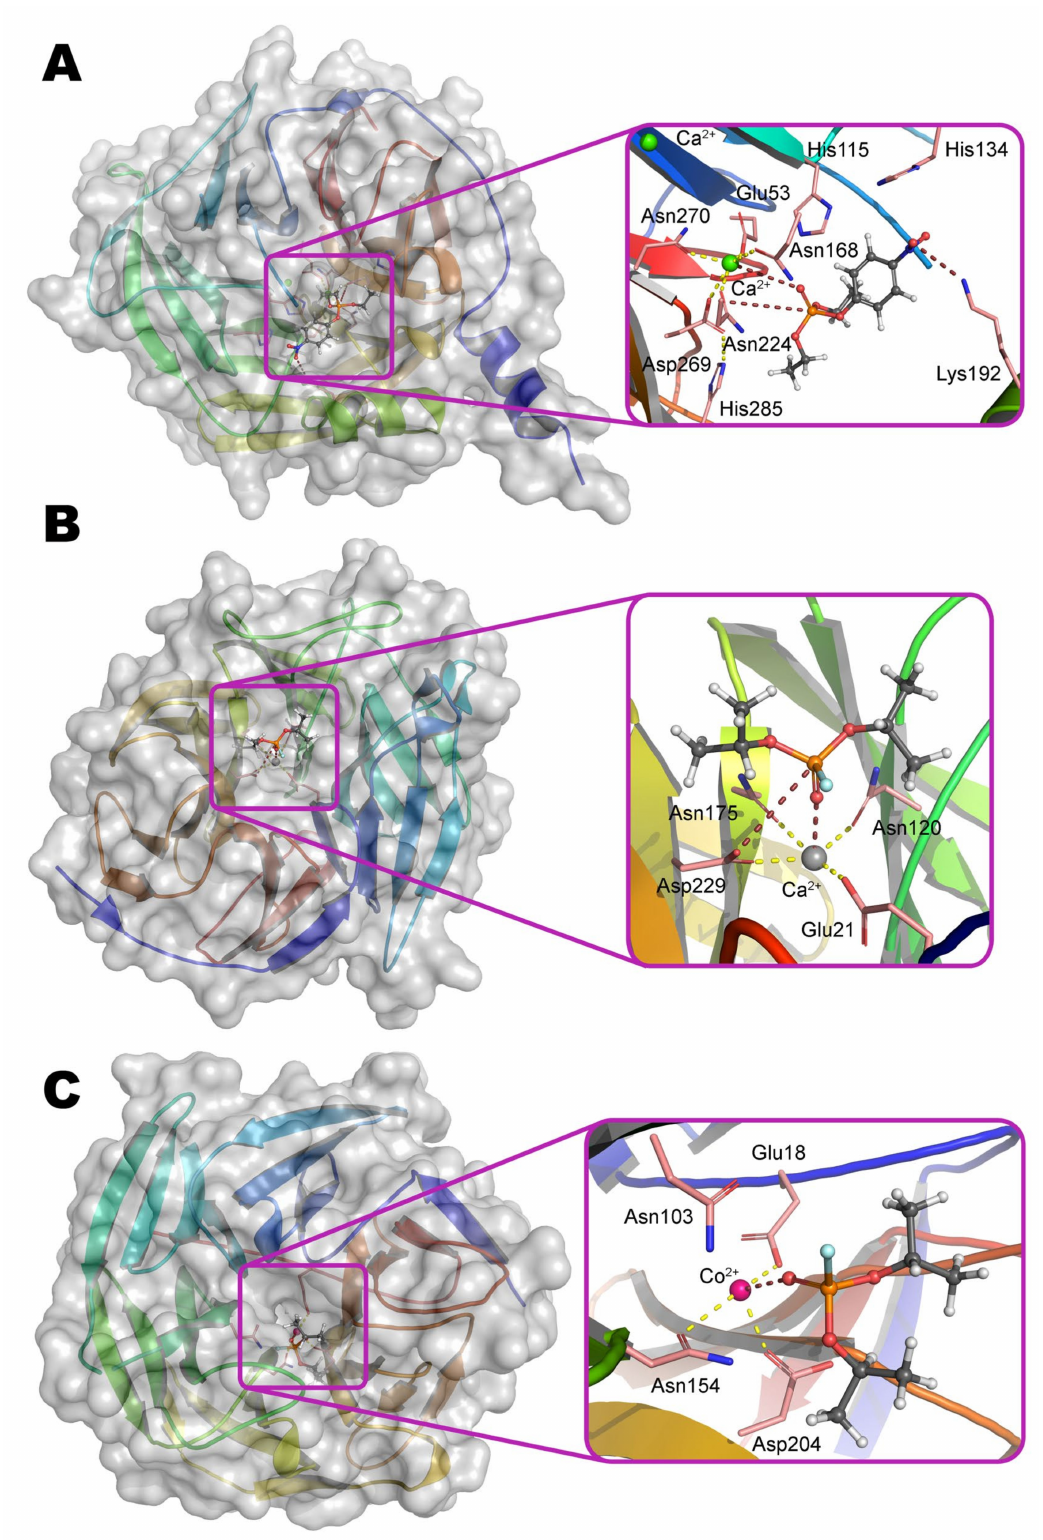
Figure 8. The structure of modified PON1 ( A ), DFPase ( B ), and SMP30 ( C ) according to X-ray diffraction data (PDB 1V04, 2GVV, and 3G4E, respectively). The entrance to the active centers of the enzymes is framed, and their structures are shown in detail within insets. The binding of the substrate paraoxon ( A ) and diisopropyl fluorophosphate ( B , C ) was determined as previously. The coordination bonds of metal ions with amino acid residues in active centers, as well as with labile groups of the substrate are shown by a dashed